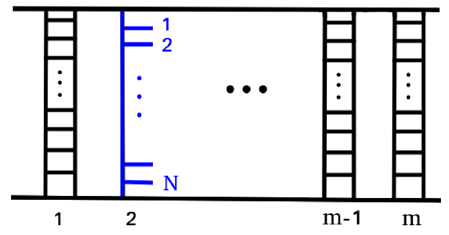
Figure 2. Same as (cid:12)gure 1 with reggeized gravitons (or gravi-reggeon). In blue, a cut gravi-reggeon contributing to the inelastic production of